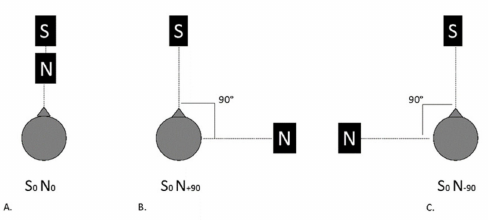
Figure 2. Speech-in-noise test setup. S, signal (speech) source location, N, noise source location. ( A ) Loudness summation test; ( B ) Right squelch effect test; ( C ) Left squelch effect